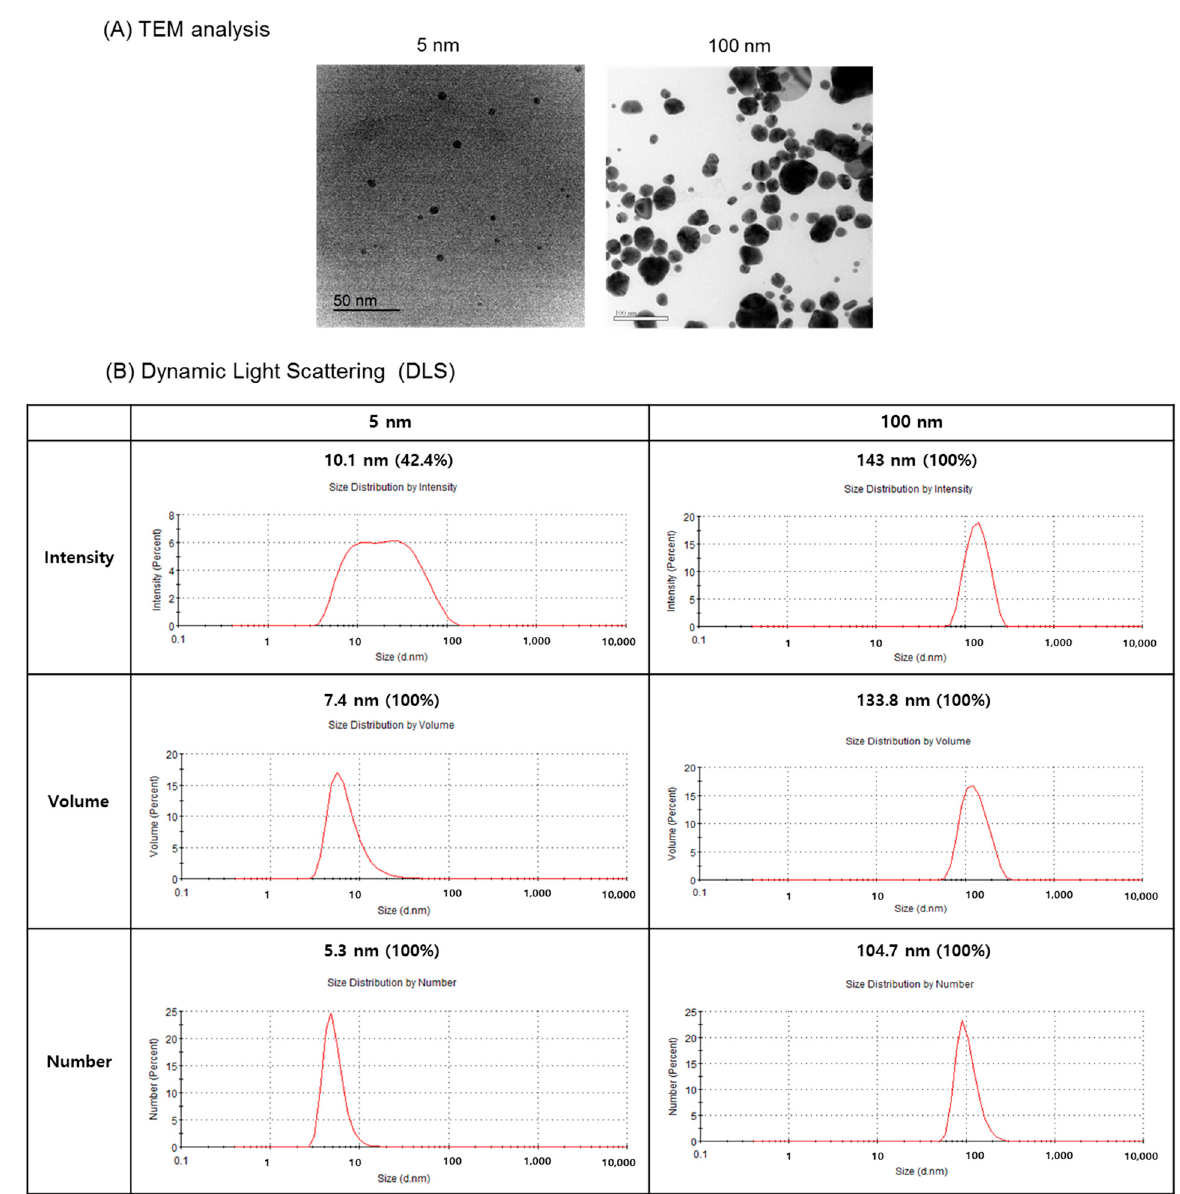
Figure 1. Analysis of silver nanoparticles (NPs). ( A ) Transmission electron microscopy images show that the 5 nm silver NPs were relatively uniform in size, whereas the 100 nm silver NPs were varied in size. ( B ) For DLS analysis, silver NPs were dispersed in DMEM containing 10% FBS.